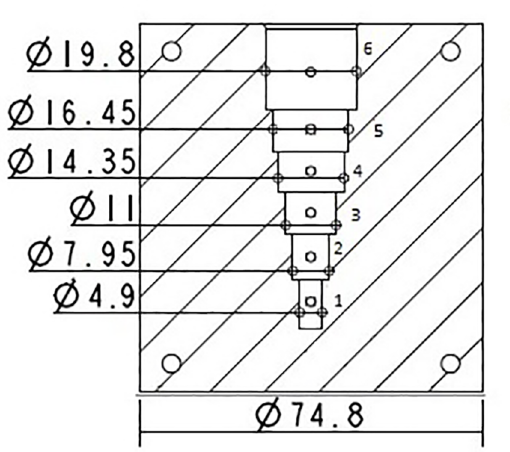
Figure 1. Schematic of six-stepped cylindrical steel mold used in the present